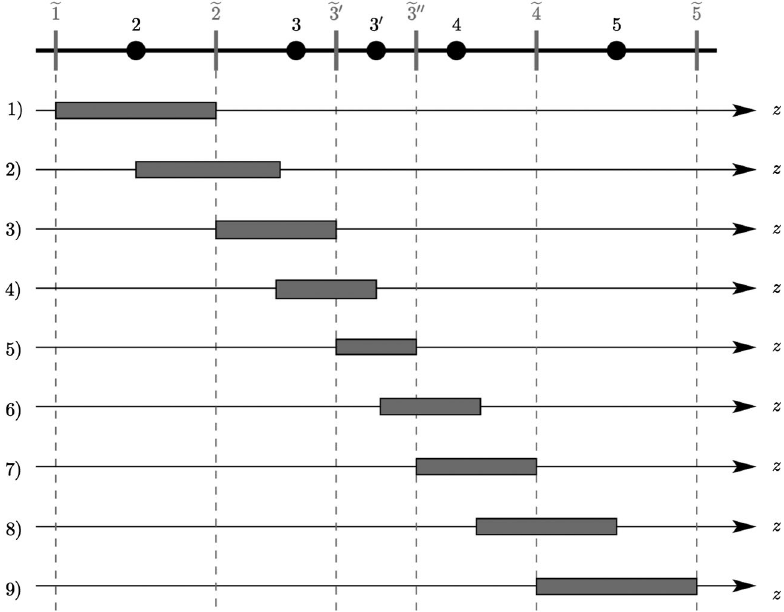
FIG. 9. Illustration of the adaptation of the particle cloud size in one dimension. The size of the particle cloud relates to the extent of the covered cells on the dual grid. If the particle is centered within a dual grid cell (cases 1, 3, 5, 7, and 9), the sizes of the cloud and the dual volume coincide. Otherwise, the cloud has to be adapted asymmetrically around the particle position. For cases 2 and 4 the charge density within the part of the cloud in the dual volumes for cases 6 and 8, the charge density of the cloud in the dual volumes